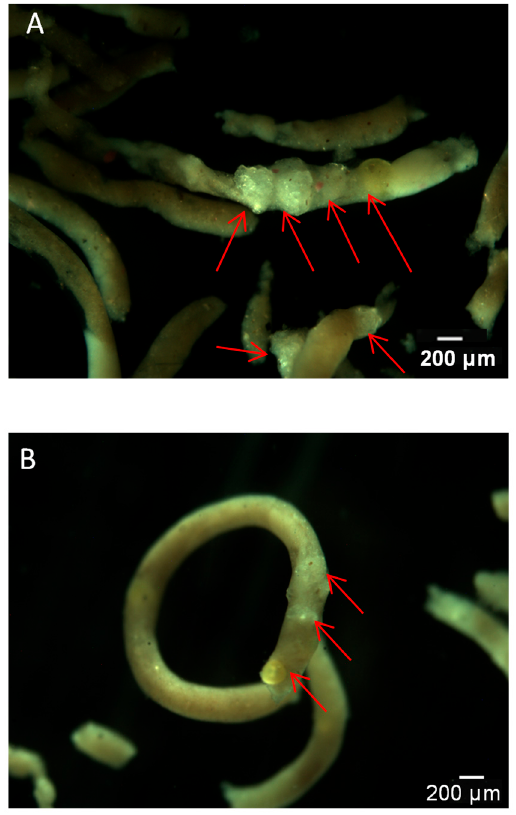
Figure 2. Feces of B. glabrata with fragments and spheres upon exposures to 4 particles/mL polyethylene microbeads for 48 h ( A ) and 0.4 particles/mL polyethylene microbeads for 21 d ( B ).